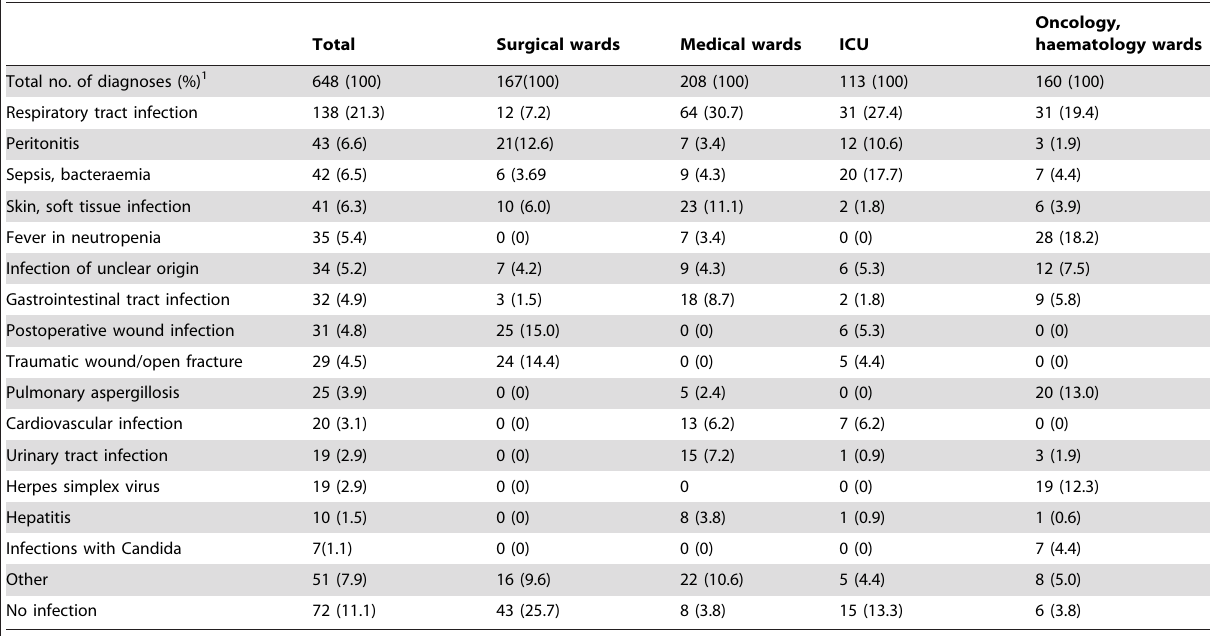
Table 3. Main indications for antimicrobial therapy.